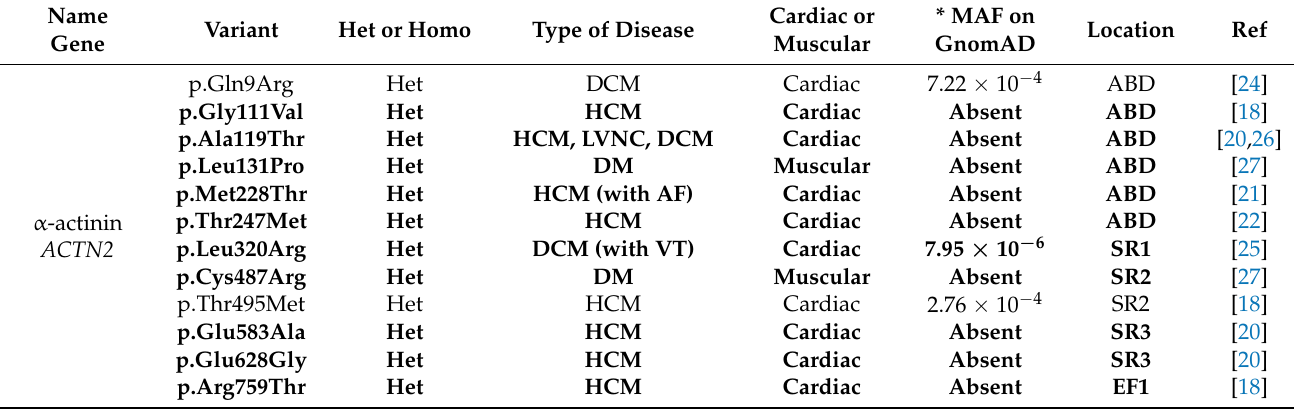
Table 1. Variants in the ACTN2 gene that have been previously reported in individuals with myopathy or cardiomyopathy. Name